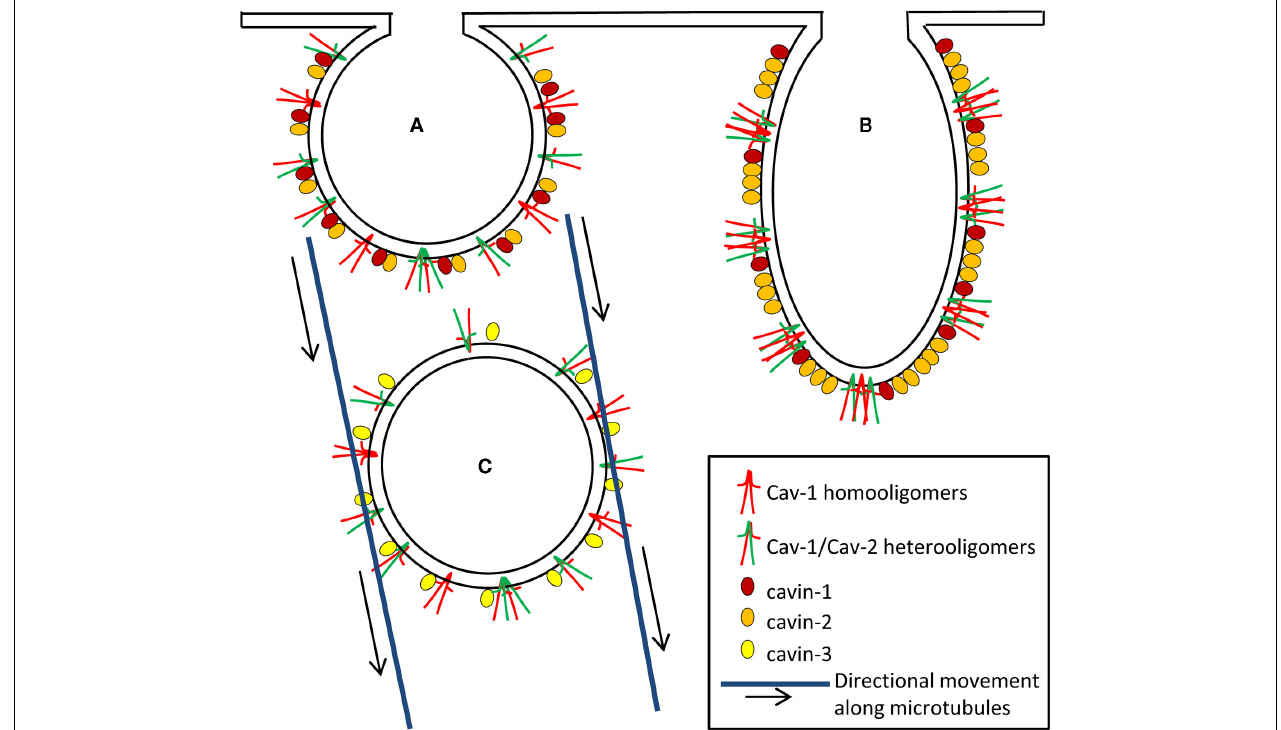
in decreased protein stability of caveolins). Cavin-2 and cavin-1 interact with each other and cavin-2 promotes recruitment of cavin-1 to caveolae. Cavin-2 downregulation induces loss of cavin-1 and Cav-1 expression and thereby limits caveolae formation. (B) Cavin-2 is thought to be a necessary component for inducing membrane-curvature of caveolae (Overexpression of cavin-2 induces elongated caveolar morphology as well as caveolae-associated tubule formation). (C) Cavin-3 associates with Cav-1 upon caveolae internalization to form vesicles and its absence markedly reduces intracellular Cav-1 traffic along